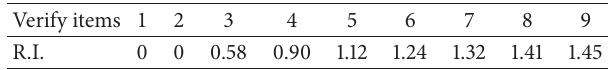
Table 4: R.I. Value